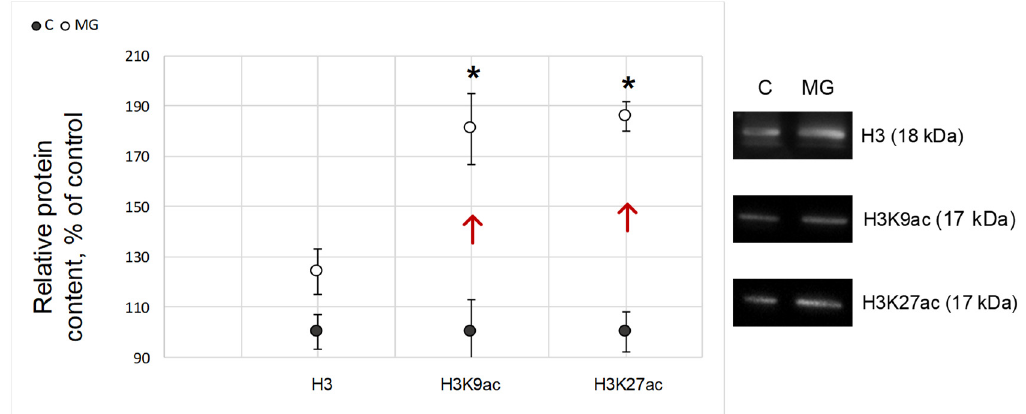
Figure 4. Relative content of proteins that form the nucleosomal core and participate in DNA organization in Drosophila melanogaster oocytes. H3 (18 kDa)—histone H3; H3K9ac (17 kDa)—histone H3 acetylated at Lys9; H3K27ac (17 kDa)— histone H3 acetylated at Lys27; C—control group; MG—simulated microgravity group. Arrows indicate the direction of change. * p < 0.05 compared with the control group C. Typical Western blots are shown on the right.